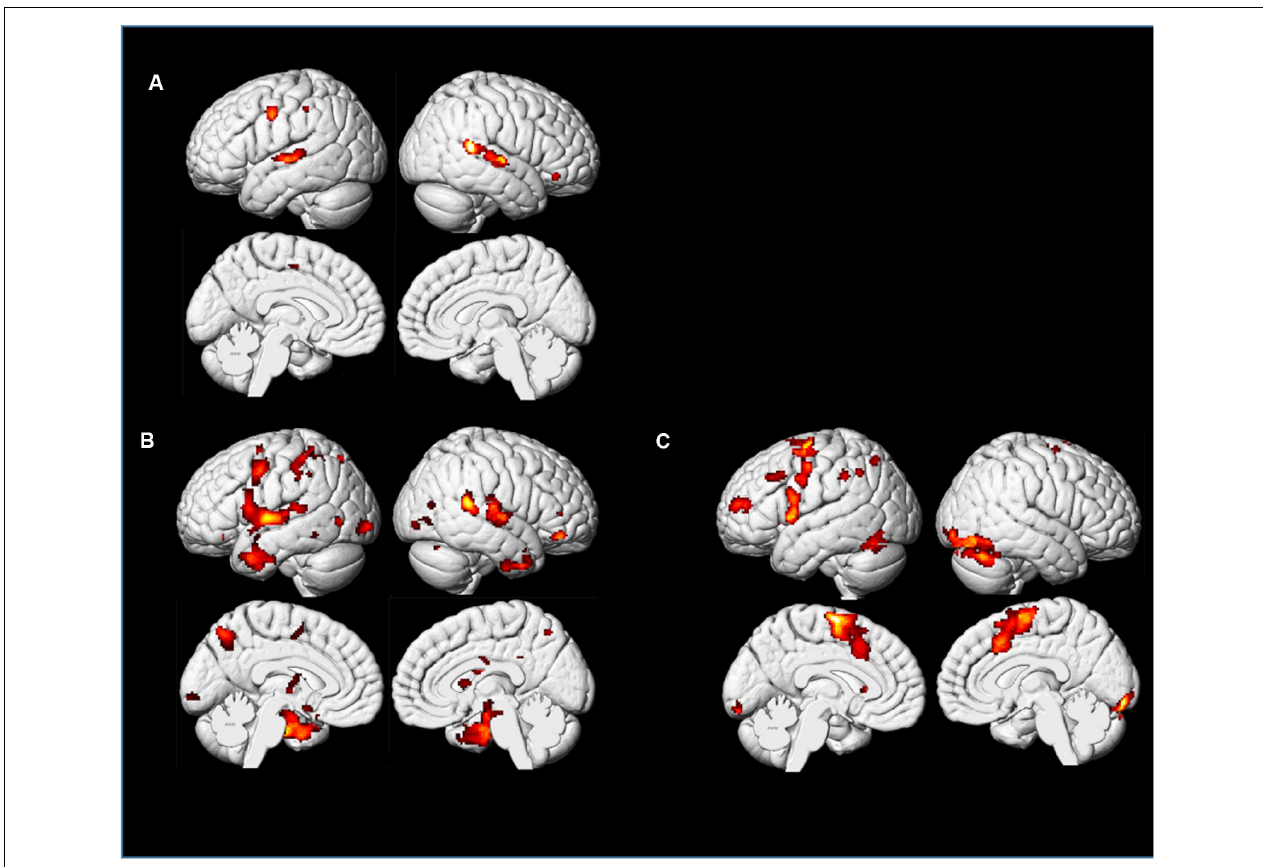
FIGURE 11 | PP’s brain: t -maps representing PP’s cortical activations for Playing, Imagining Playing, and Imagining Listening. The maps were corrected for multiple comparisons using FWE ( p < 0.05, k = 22). (A) Conjunction analysis of Imagining a melody and Listening to the same melody. (B) Conjunction analysis of Imagining Playing and actual Playing of the same piece. (C) The contrast between Imagining Playing a piece of music vs. Imagining Listening to